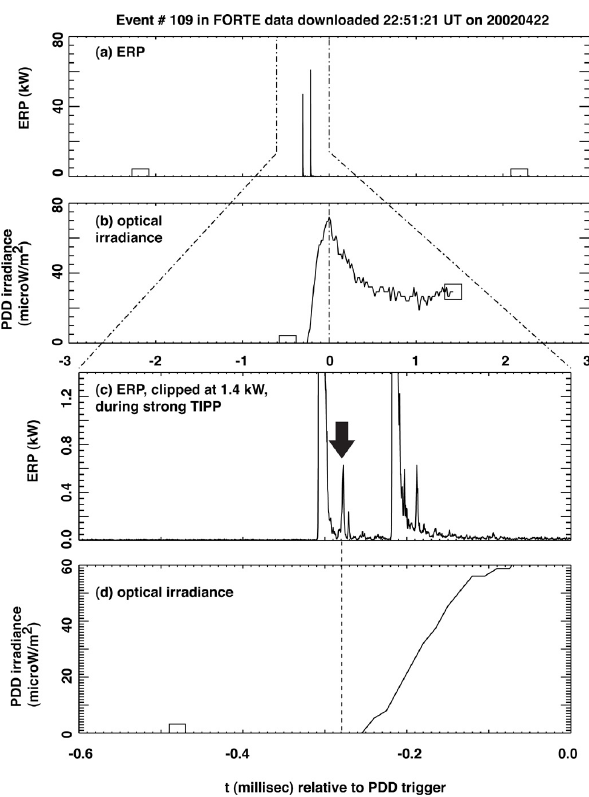
Fig. 7. Fifth of the six HUMR–PDD events of Table 4. (a) ERP vs. time. (b) Optical irradiance vs. time. (c) ERP vs. time, clipped at 1.4kW on the ordinate and restricted to the zoom limits shown in panel (a) . (d) Optical irradiance, restricted to the same time limits as panel (c) . Arrow marks a “secondary-breakdown pulse” in panel (c) , which is continued as a dashed line in panel (d) .